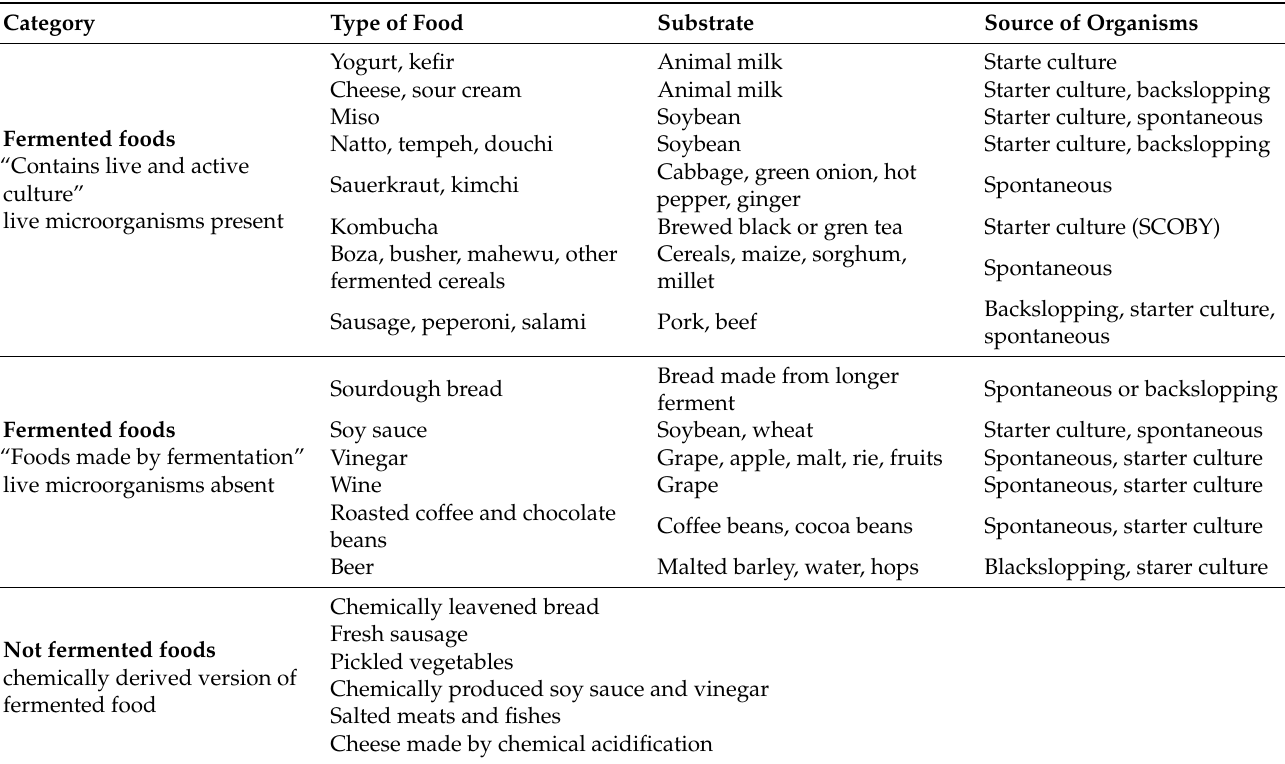
Table 1. Description of fermented foods based on